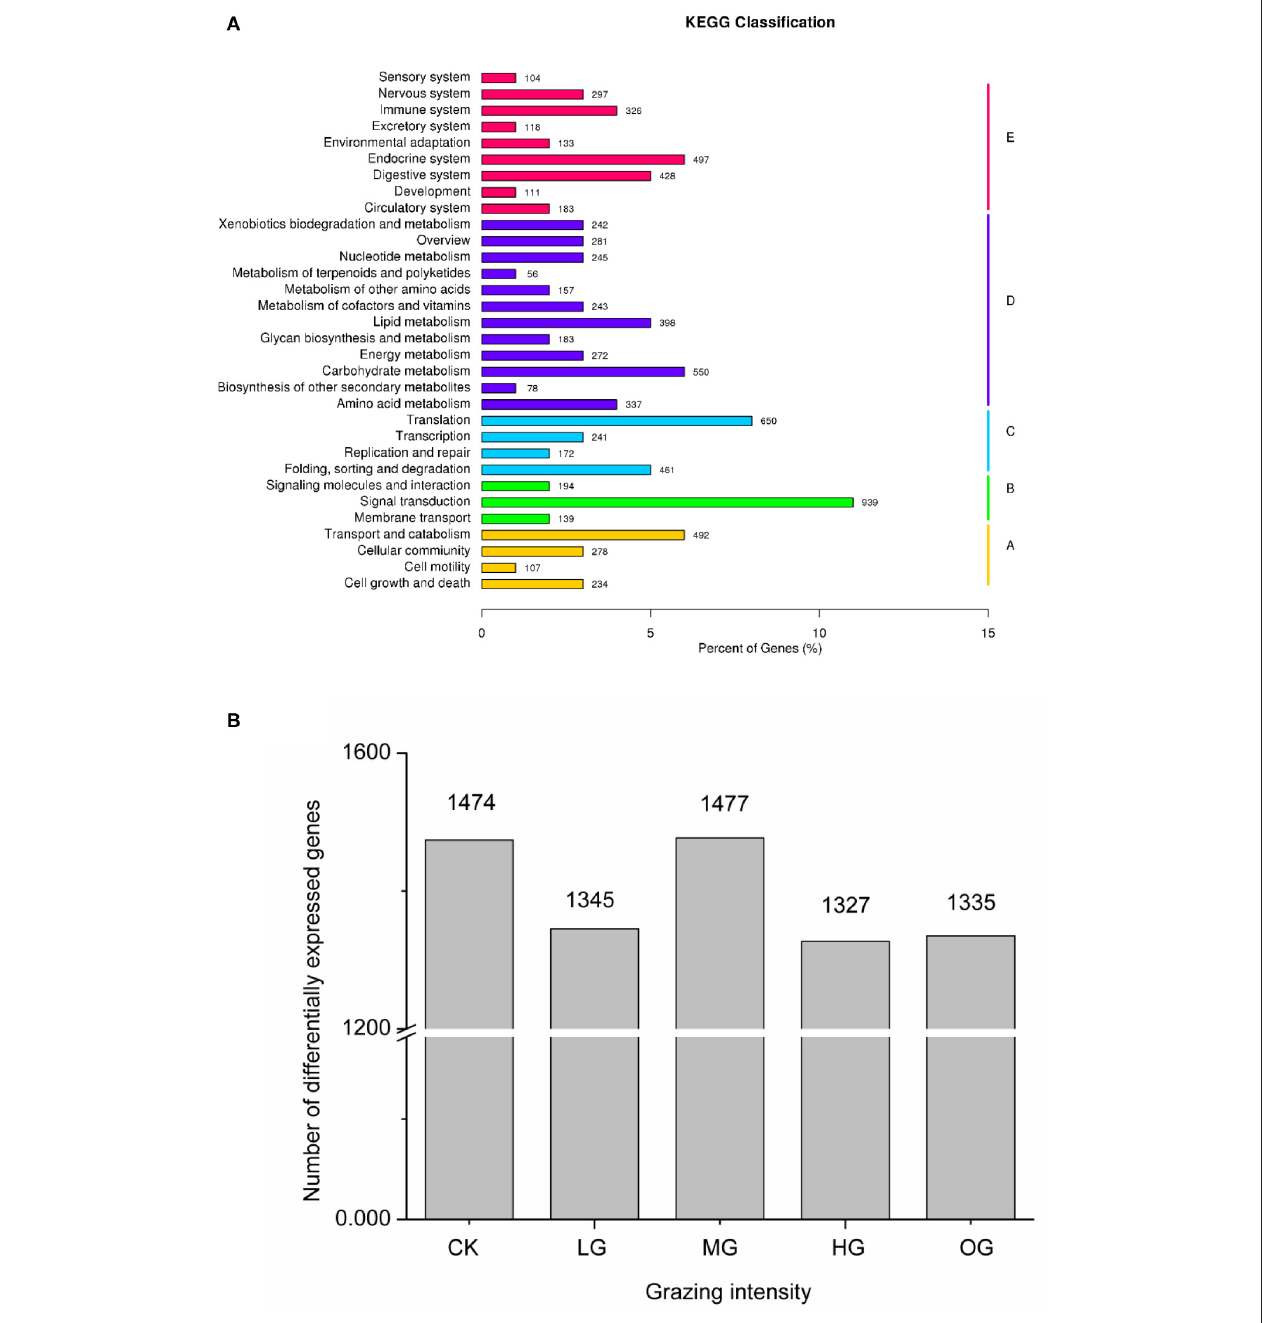
FIGURE 3 | (A) KEGG classification. The X-axis indicates the percentage of genes accounting for the KEGG items, and the Y-axis indicates the KEGG items. A, B, C, D, E indicate cellular processes, environmental information processing, genetic information processing, metabolism, organismal systems, respectively. (B) Number of differentially expressed genes of Chorthippus albonemus in response to different levels of grazing intensity. CK, indicates control (no grazing); LG, light grazing; MG, moderate grazing; HG, heavy grazing; OG,